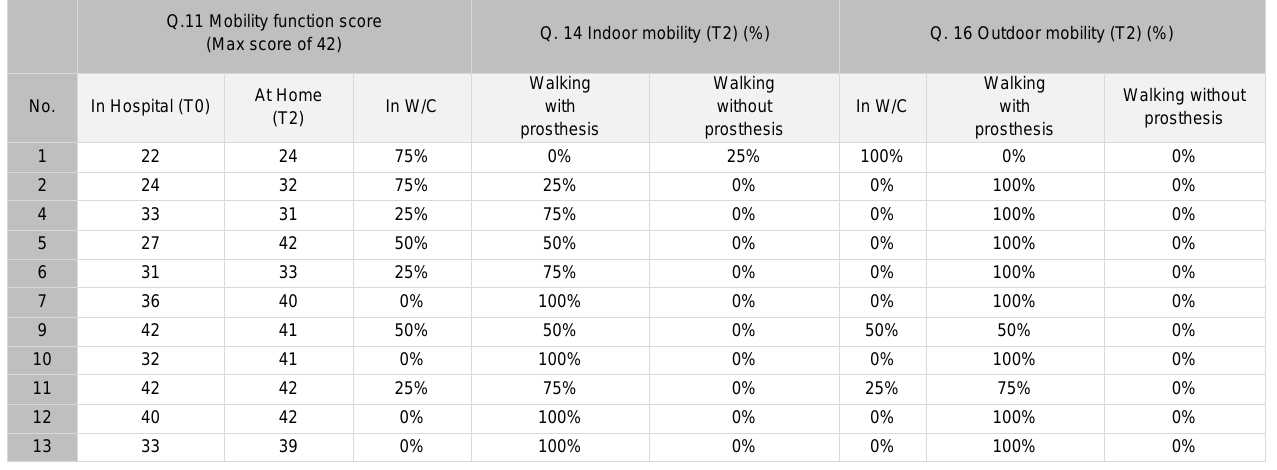
Table 2: Select questions from the Prosthetic Profile of the Amputee questionnaire. Q.11 Mobility function score Q. 14 Indoor mobility (T2) (%) Q. 16 Outdoor mobility (T2) (Max score of 42)